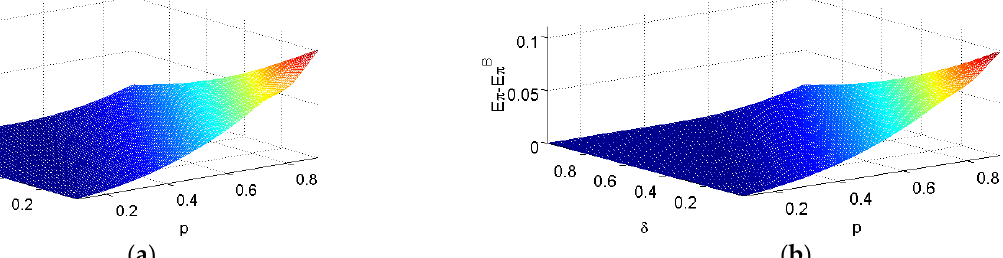
( b ) Figure 8. Impacts of